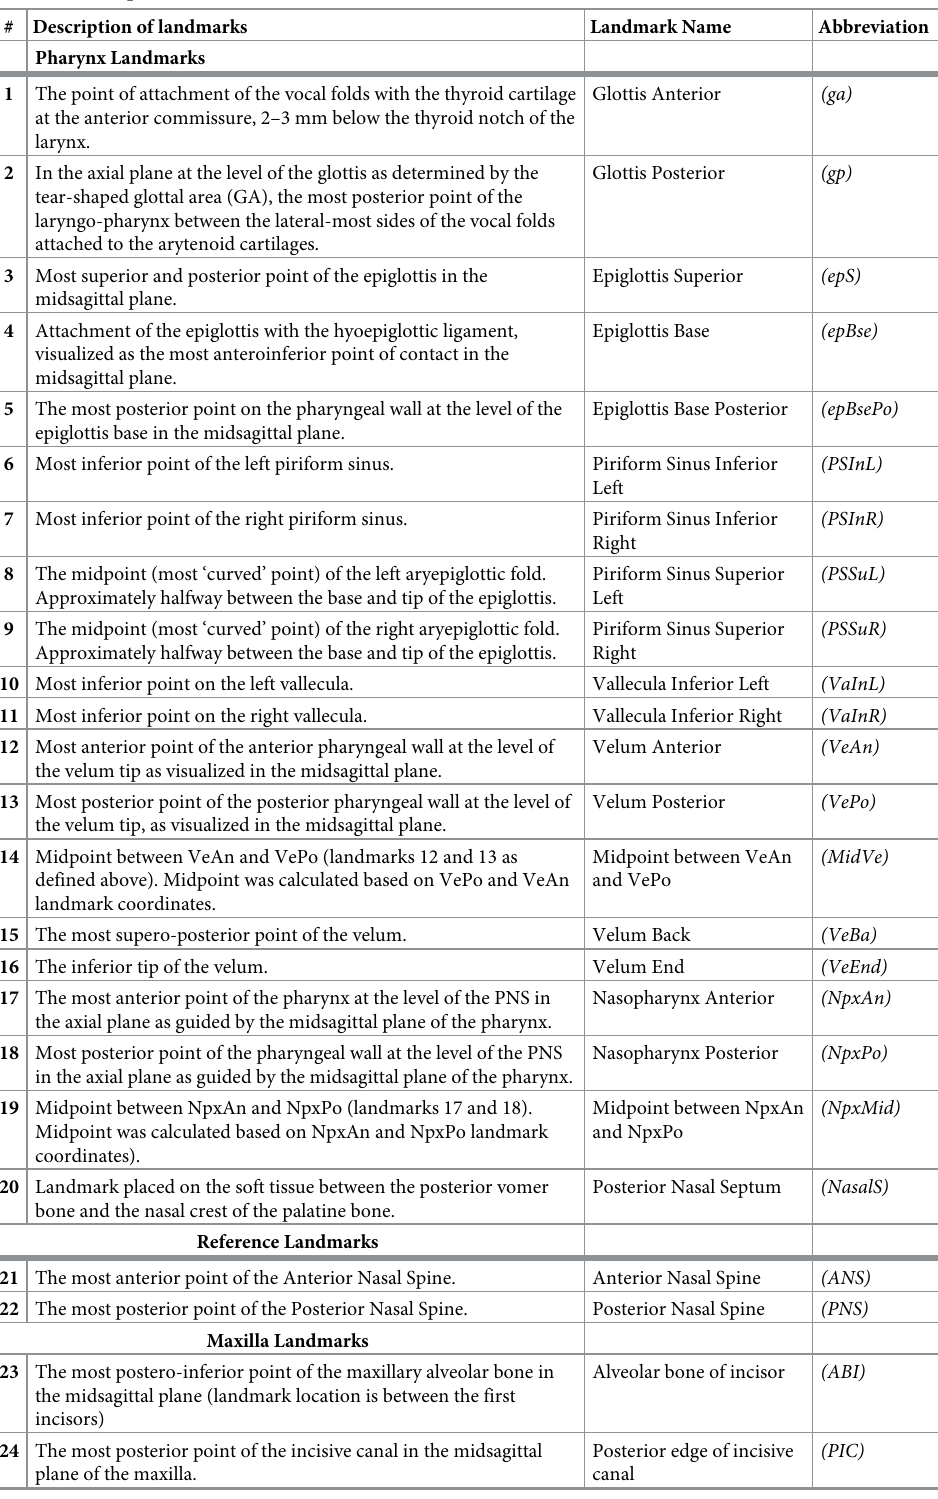
Table 4. Description/definition of the 26 anatomic